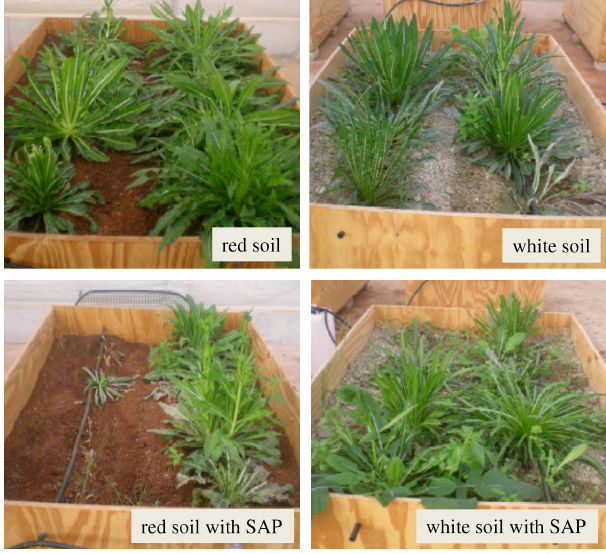
Figure 7. Comparison of the growth of chicory plants in the different types of soil, with and without the addition of SAP.